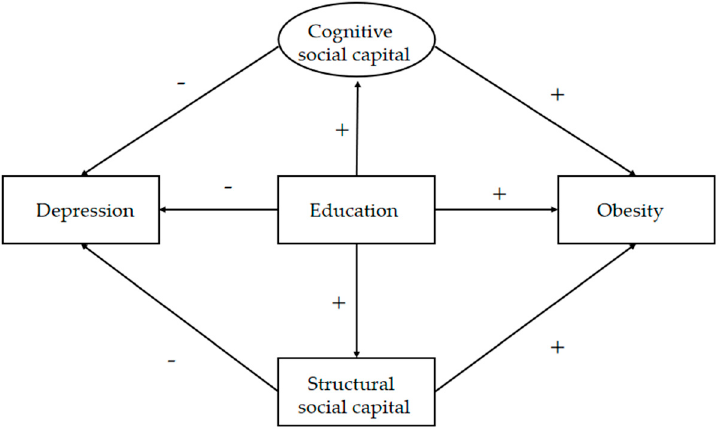
Figure 1. Conceptual framework.